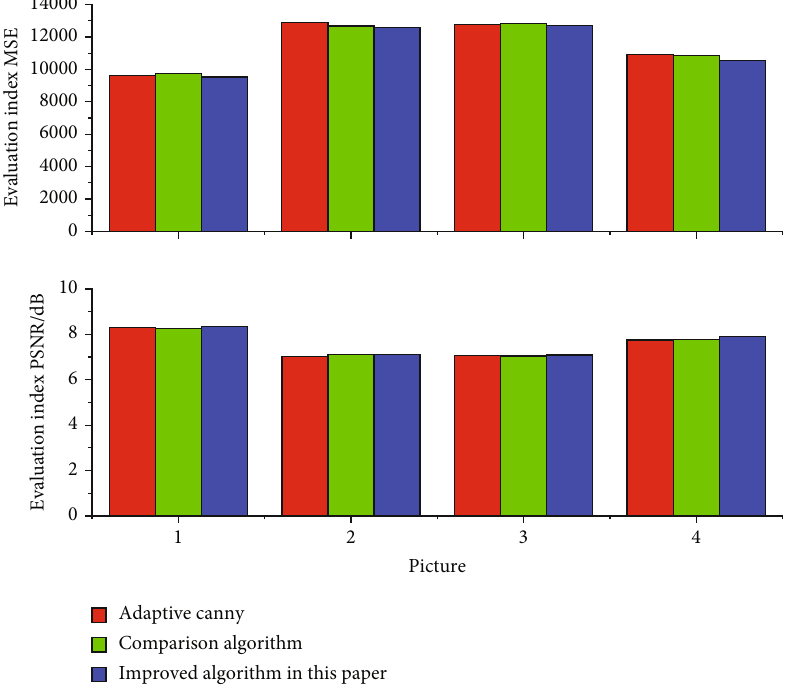
Figure 6: Quantitative analysis results of the three algorithms.